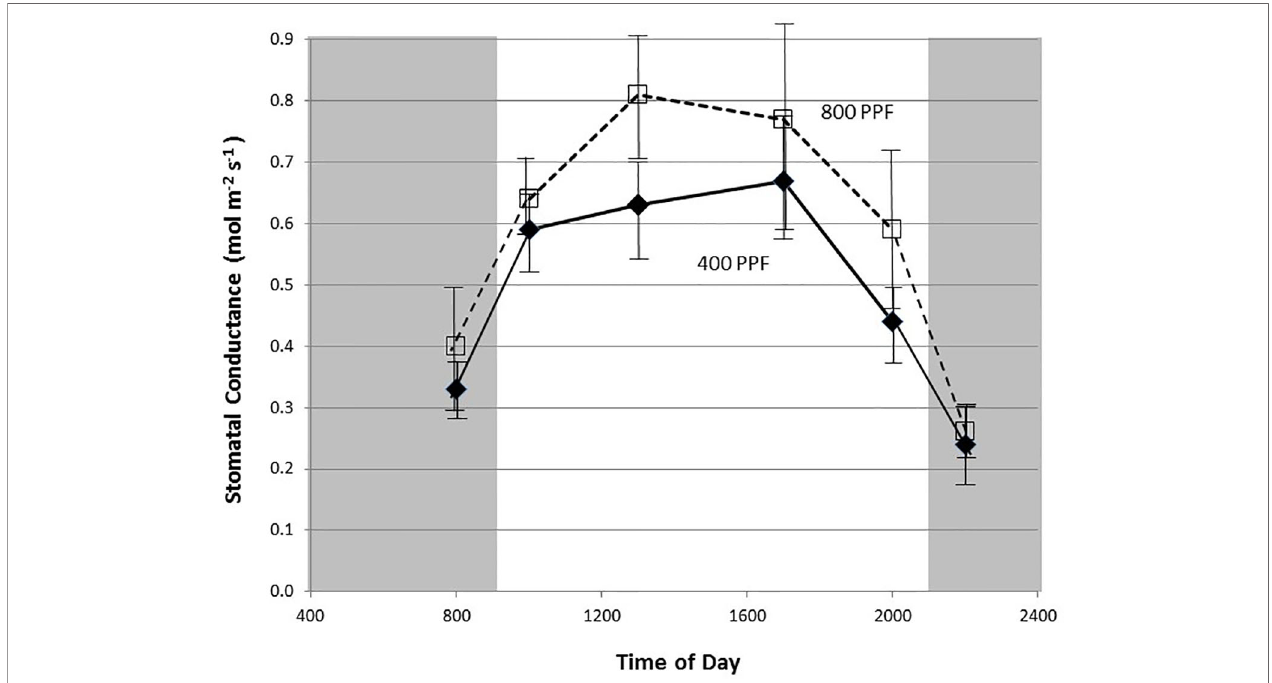
FIGURE 3 | Diurnal plot of leaf stomatal conductance rates for young, fully expanded potato leaves of cv. Denali grown under a 12-h light and 12-h dark photoperiod at 350 ppm [CO 2 ]. Plants were grown at either 400 or 800 µmol m − 2 s − 1 photosynthetic photon fl ux (PPF). Each point represents n = 12 measurements from separate leaves with standard deviation bars